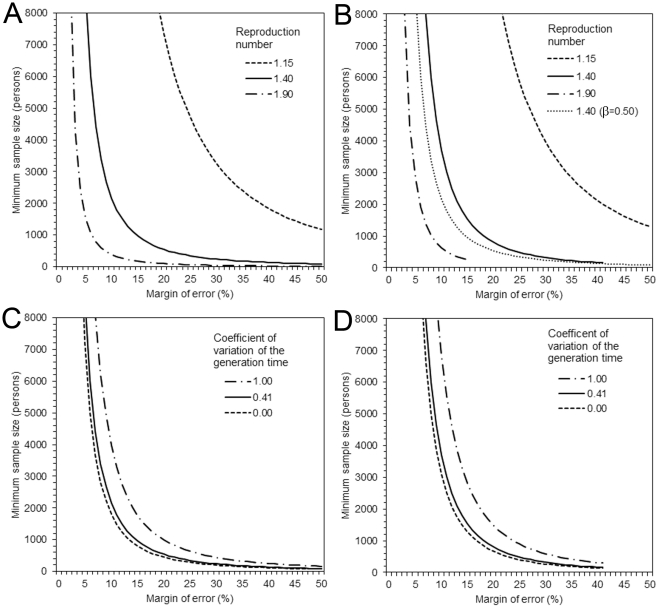
Minimum sample sizes required for post-epidemic seroepidemiological studies of final size as a function of the margin error, the reproduction number, and the coefficient of variation of the generation time.(A & B) Sample size with three different reproduction numbers as a function of the margin of error. (A) employs an estimation formula based Type I error alone (at α = 0.05), while (B) accounts for both Type I and II errors (at α = 0.05 and 1−β = 0.80). The margin of error represents random sampling error, around which the reported percentage would include the true percentage. Since (A) is a special case of (B) (with β = 0.50), R = 1.40 in (A) is also shown as dotted line in (B). The coefficient of variation (CV) of the generation time and the proportion of population with pre-existing immunity are fixed at 40.7% and 7.5%, respectively. (C & D) Sample size with three different coefficients of variation as a function of the margin of error. (C) accounts for Type I error alone (α = 0.05), while (D) accounts for both Type I and II errors (α = 0.05 and 1−β = 0.80). The reproduction number and the proportion of population with pre-existing immunity are fixed at 1.40 and 7.5%, respectively. CV = 0 corresponds to a constant generation time, whereas CV = 1 represents an exponentially distributed generation time. In (B) and (D), several lines are truncated, due to impossibility to account for larger margins of error in the estimation formula.